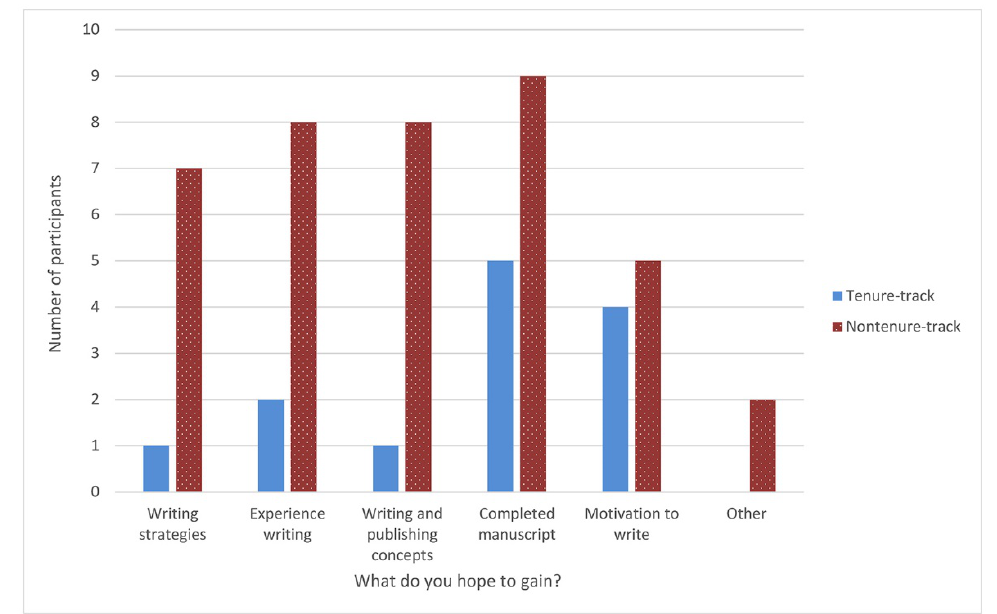
Figure 3 What do you hope you will gain by participating in the Scholarship